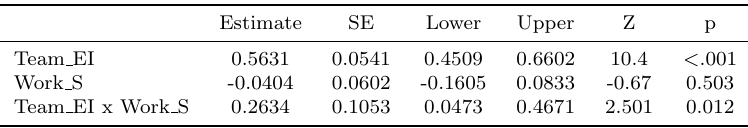
Table 3: Moderation Estimates